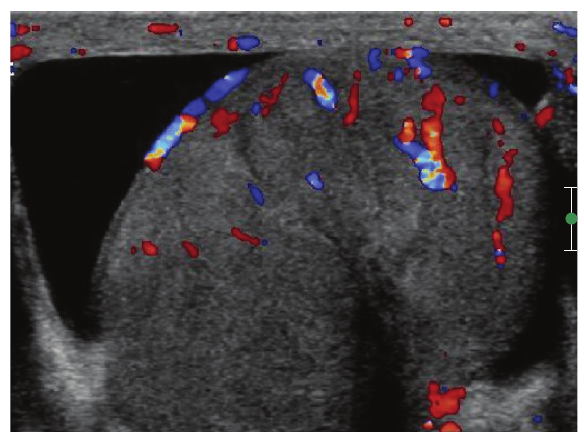
Figure 1: A scrotal USS revealed an enlarged testis with hypervas- cularity compatible with orchitis, May 2010.